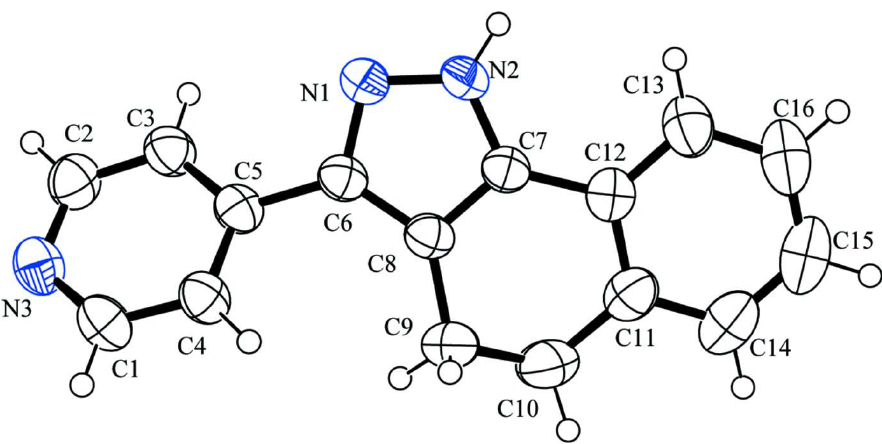
Figure 1 The molecular structure of (I) showing the atom-labeling scheme. Displacement ellipsoids are drawn at the 50% probability